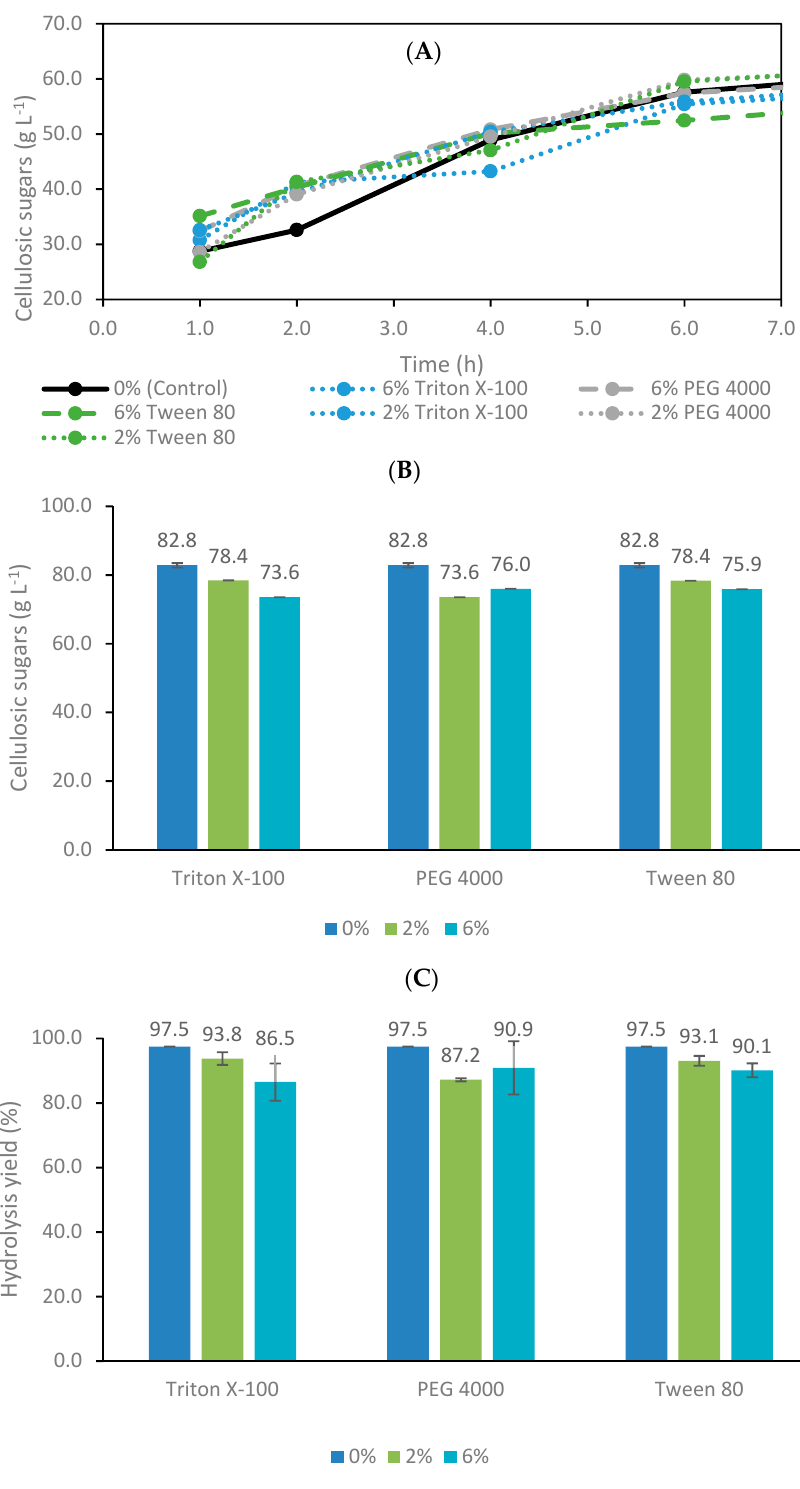
Figure 1. ( A ) Time course for cellulosic sugars concentration at the initial stage of the enzymatic hydrolysis experiments. ( B ) Concentration of cellulosic sugars after 24 h of enzymatic hydrolysis. ( C ) Hydrolysis conversion efficiency of additive experiments after 24 h of operation.